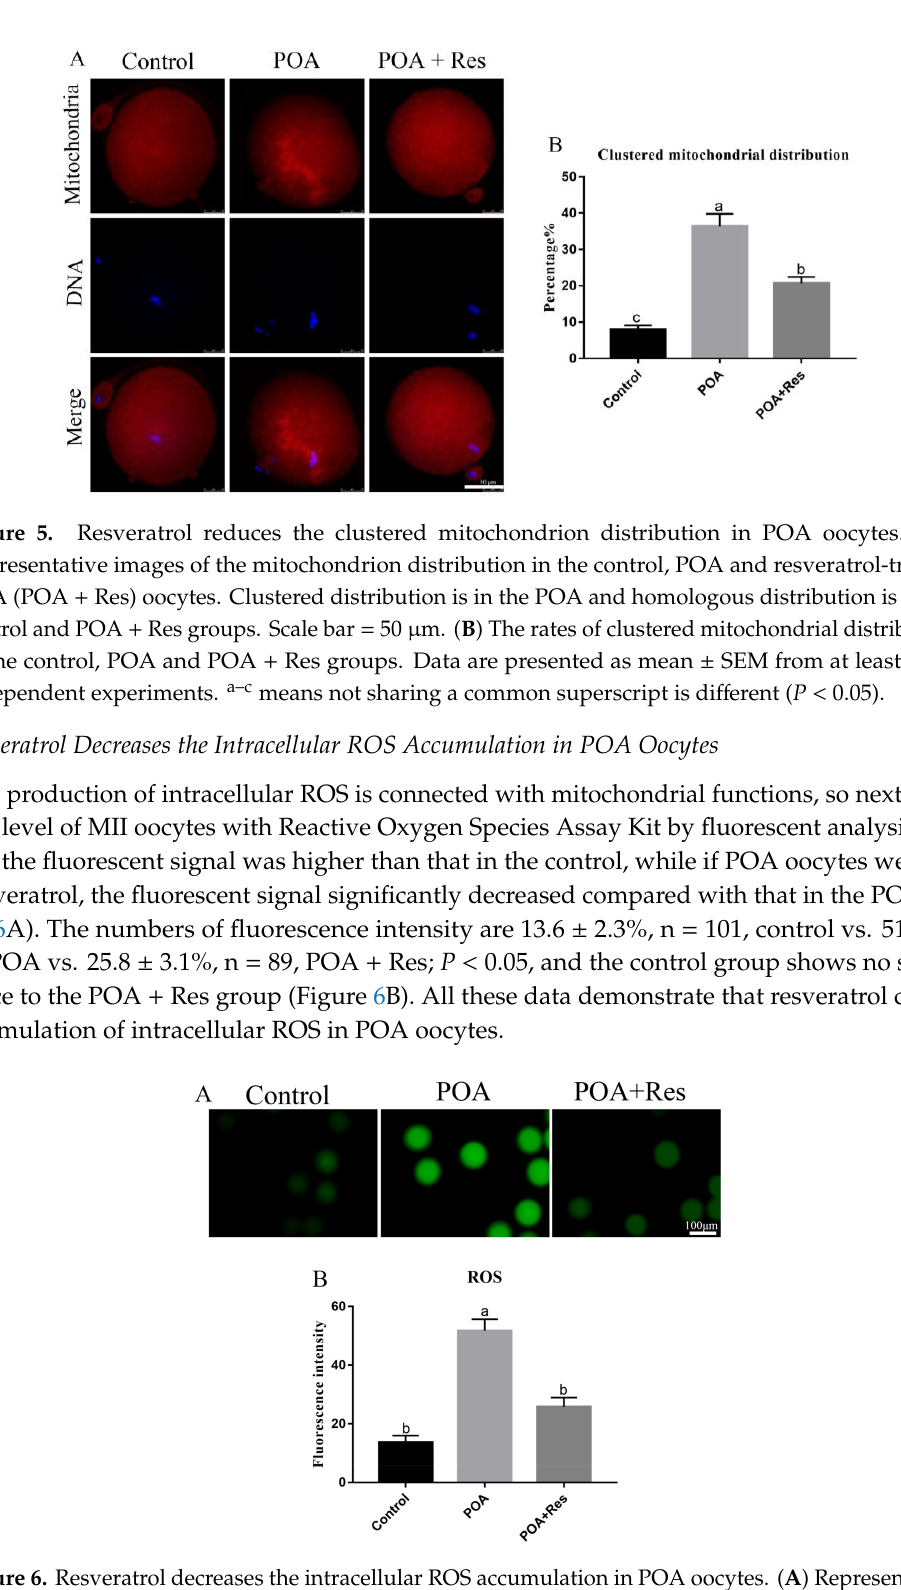
Figure 6. Resveratrol decreases the intracellular ROS accumulation in POA oocytes. ( A ) Representative images of reactive oxygen species (ROS) (green) in the control, POA and resveratrol-treated POA (POA + Res) oocytes detected with Reactive Oxygen Species Assay Kit. Scale bar = 100 µ m. ( B ) The fluorescence intensities of ROS in the control, POA and POA + Res groups. Data are presented as mean ± SEM from at least three independent experiments. a,b means not sharing a common superscript is di ff erent ( P <